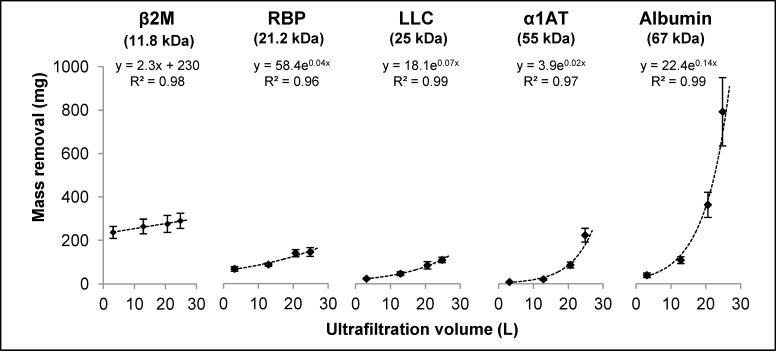
Removal of five different protein compounds in mg/session, analysed following the convection volumes obtained in the different dialysis conditions.It is observed that the variation in β-2m removal was not significantly different with HDF (slight linear increase with increasing convection volume), while the increase in removal was more evident in the higher mol wt range, being clearly exponential for albumin; albumin loss was around double when increasing from optimal convection to maximum convection HDF.